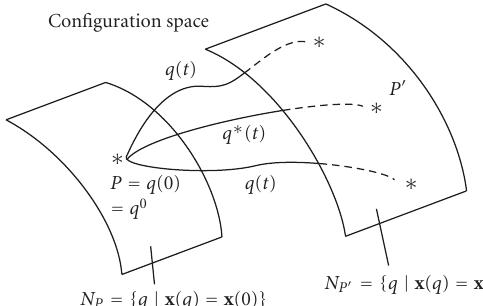
Figure 4: A set of all postures that have the same endpoint position x d constitutes a two-dimensional Riemannian